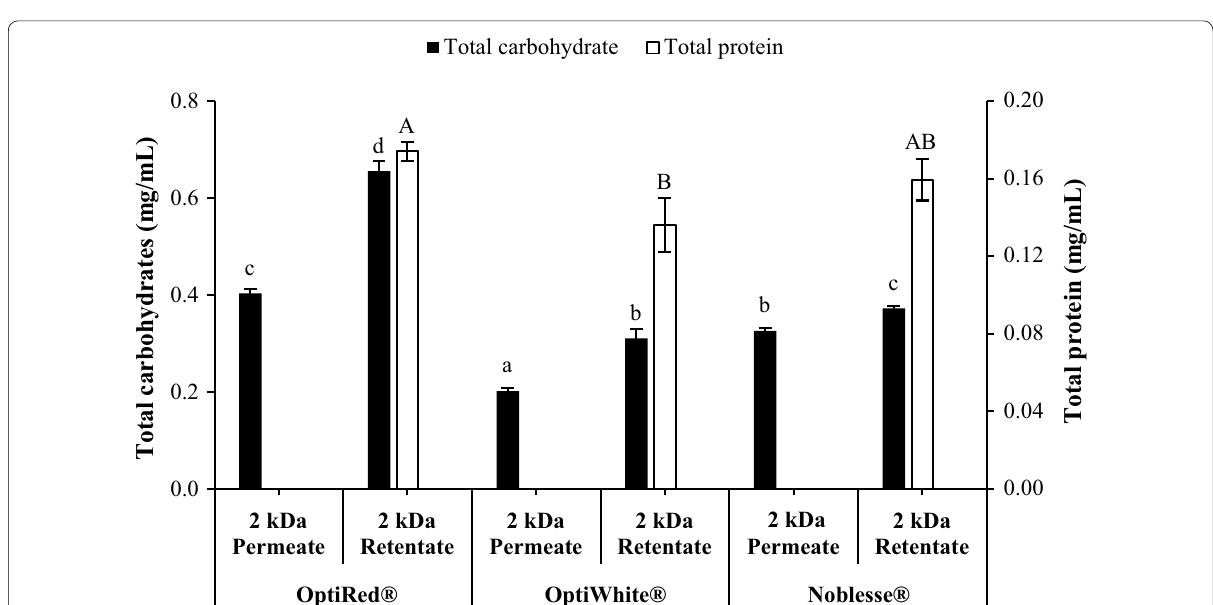
Values are expressed as the mean standard deviation of three independent experiments ( n ± letters are significantly different ( P < 0.05) for 0 h and 10 h, respectively. Mean values denoted with * indicate significant difference ( P < 0.05) between concentrations